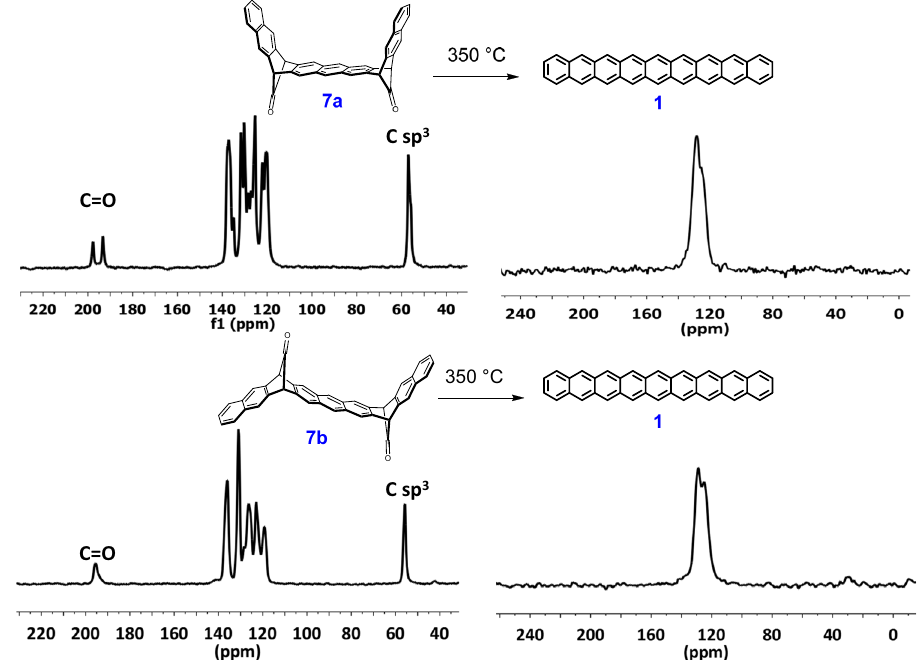
Fig. 8 Thermal decarbonylation of the precursors. Evolution of the CPMAS spectra of 7a/7b by decarbonylation at 350 °C for 20 min to form the nonacene 1 .